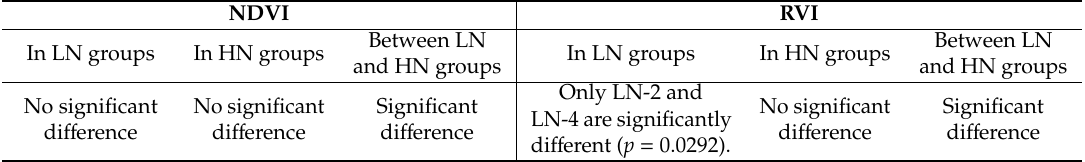
Table 4. Results of multiple comparison tests for NDVI and